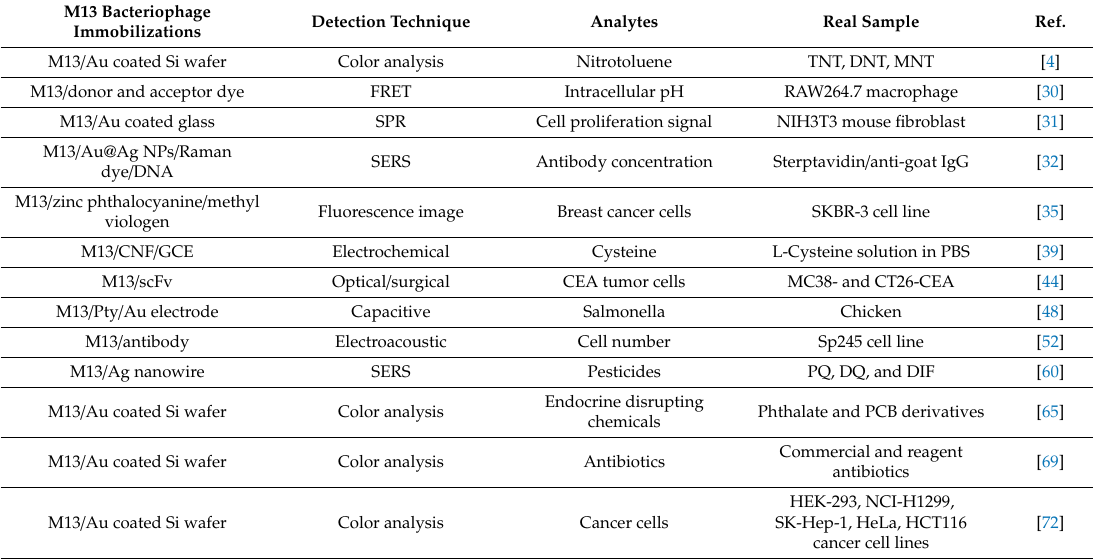
Table 1. Biosensor applications of M13